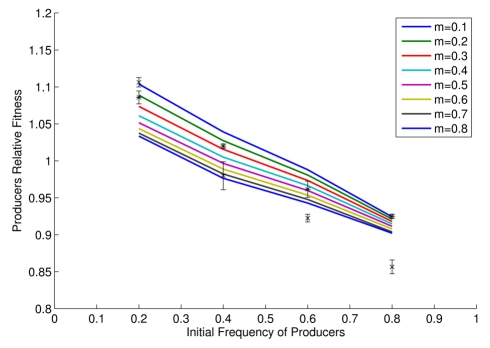
Relative producer fitness as a function of initial frequency in theory (lines) and practice (points (*); mean ± s.e.m.; n = 3).Asterisks represent poorly mixed cultures (m low) while data points marked with an x represent better mixed cultures (m high).